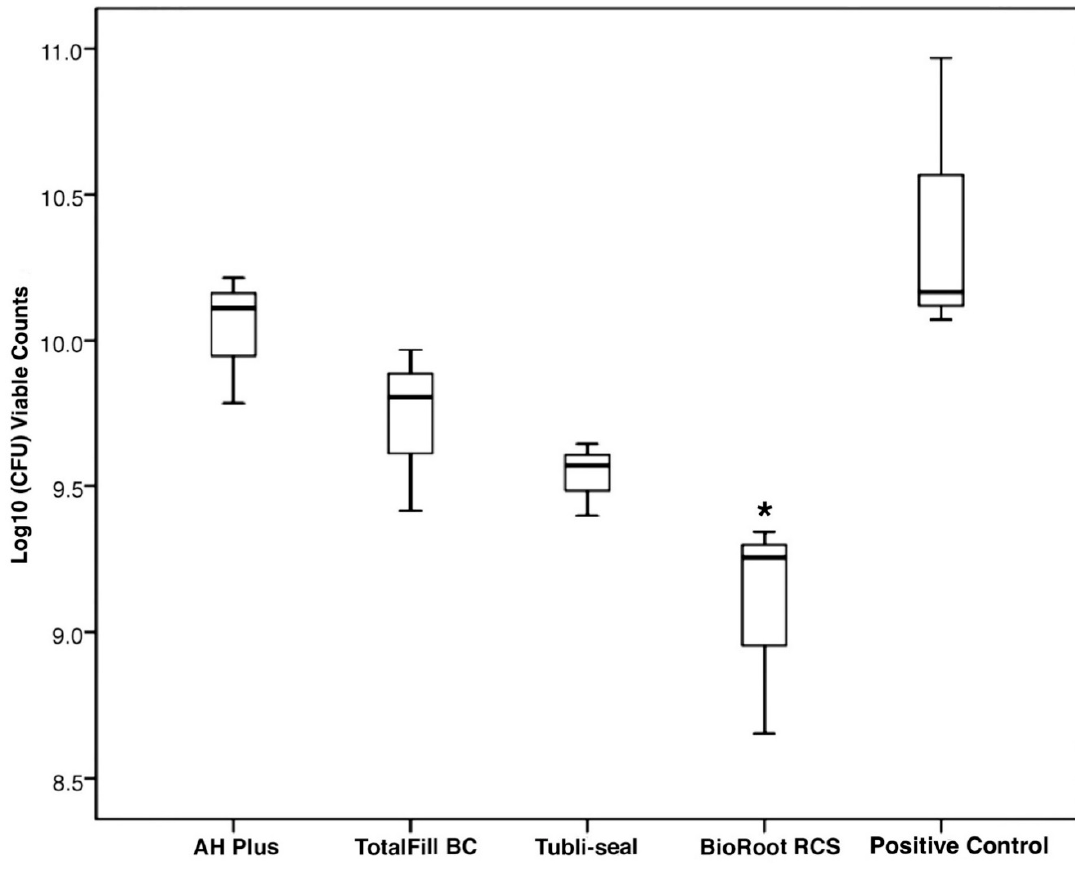
Figure 2. Boxplot showing viable counts (log10CFU) following biofilm growth on set sealer discs, * viable counts significantly less compared to AH Plus and control ( p < 0.05). Negative control group presented nondetectable viable counts.